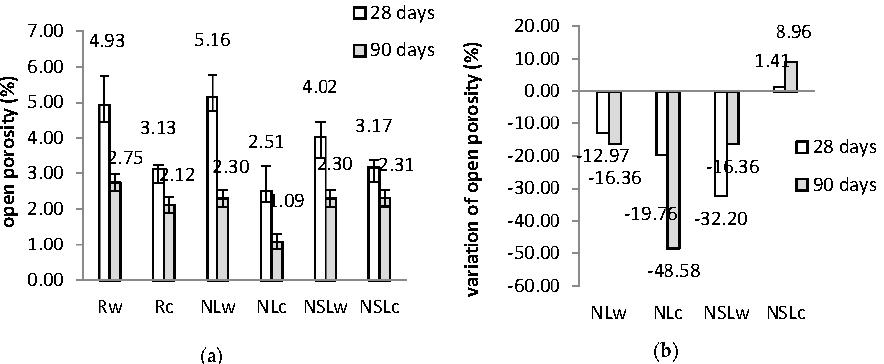
Figure 3. ( a ) Open porosity evolution of the pastes at 28 and 90 days; ( b ) Open porosity variation of nano-modified cement pastes, in respect to the reference.